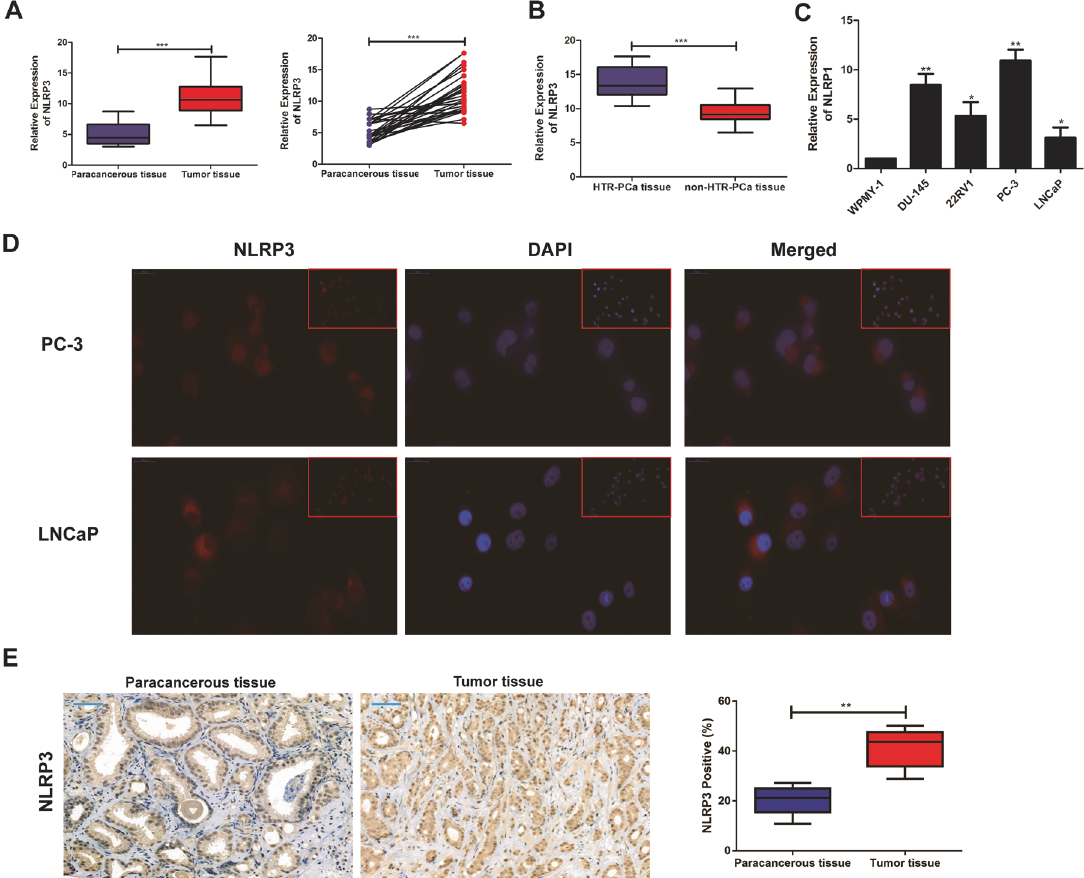
Fig. 1 NLRP3 expression level was upregulated in PCa cell lines and tissues. A qRT-PCR was used to detect the difference expression of NLRP3 in tumor tissues and corresponding paracancerous ones of PCa patients. B qRT-PCR was used to detect the difference expression of NLRP3 in the hormone therapy refractory prostate cancer (HTR-PCa) tissues and the non-hormone therapy refractory prostate cancer (HTR- PCa) ones of these patients. C qRT-PCR was used to detect the expression level of NLRP3 in PCa cell lines. D The subcellular localization of NLRP3 detected in PC3 and LNCaP cell lines by FISH assay (magni fi cation: ×40). E Immunohistochemical staining showed the difference expression of NLRP3 in tumor tissues and corresponding paracancerous ones of PCa patients. Data are mean ± SD, * p < 0.05, ** p < 0.01, *** p <